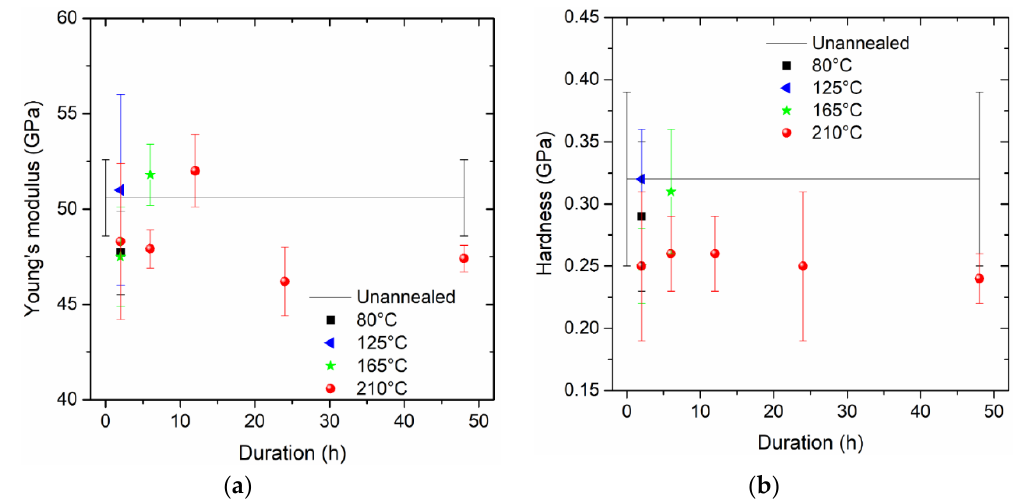
Figure 5. Measured value of hardness as a function of indentation depth.